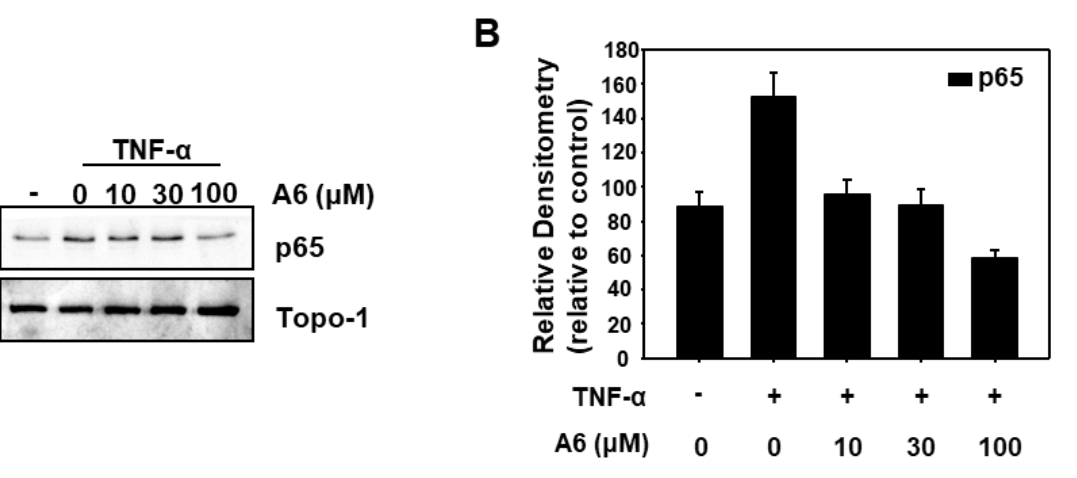
Figure 3. Compound 6d inhibits TNF- α -induced phosphorylation of p65. ( A ) HeLa cells were stimulated with 10 ng/mL TNF- α for 30 min after pretreatment of compounds 6d (10 µ M, 30 µ M, and 100 µ M) for 12 h. The extracts of nucleus were analyzed using Western blot with indicated antibodies against p65, and Topo-I. ( B ) A densitometric analysis was conducted to determine the relative ratios of each protein. Topo1 was used as the nucleus internal control.